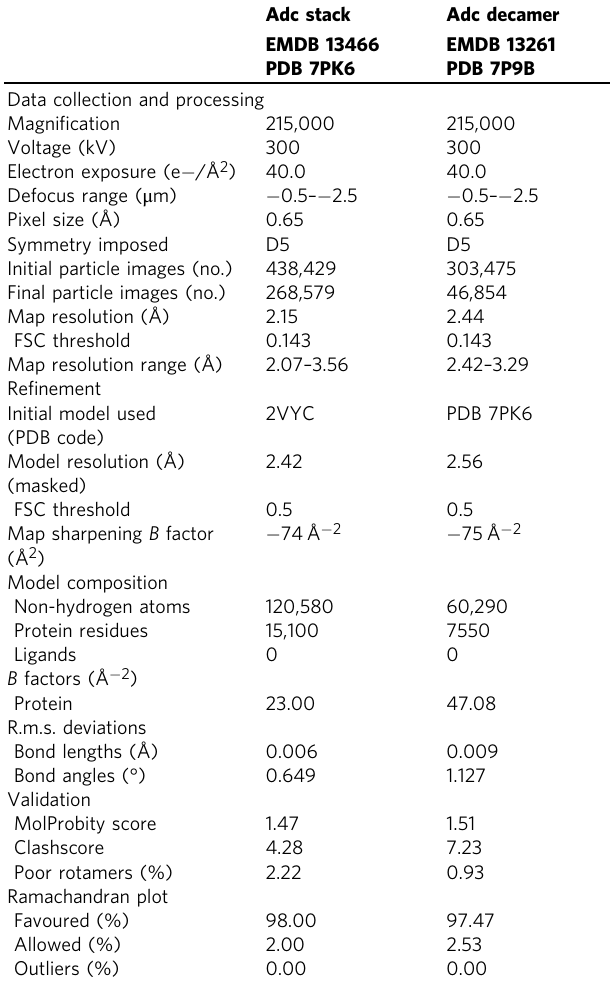
Table 1 Cryo-EM data collection, re fi nement and validation